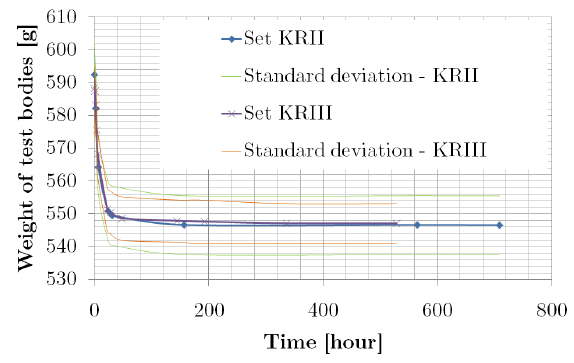
Figure 6. Time course of the test bodies average weight.